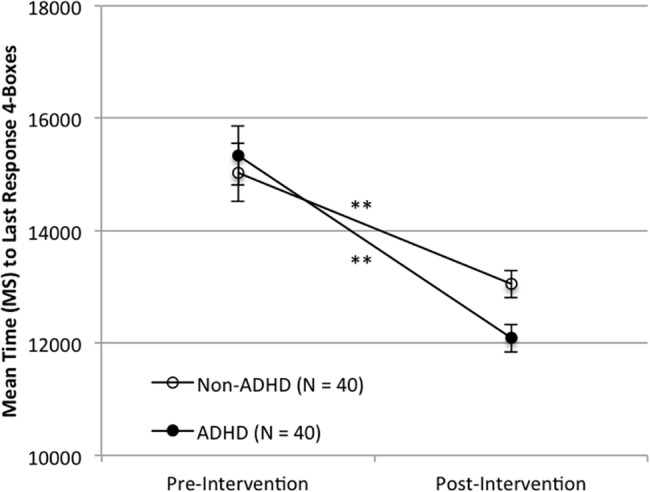
Performance on the spatial working memory task pre- and post-intervention for the ADHD group and the non-ADHD group.Note. Scores represent mean time to last response with 4 boxes. Error bars represent standard error of the mean. (** p < 0.005).